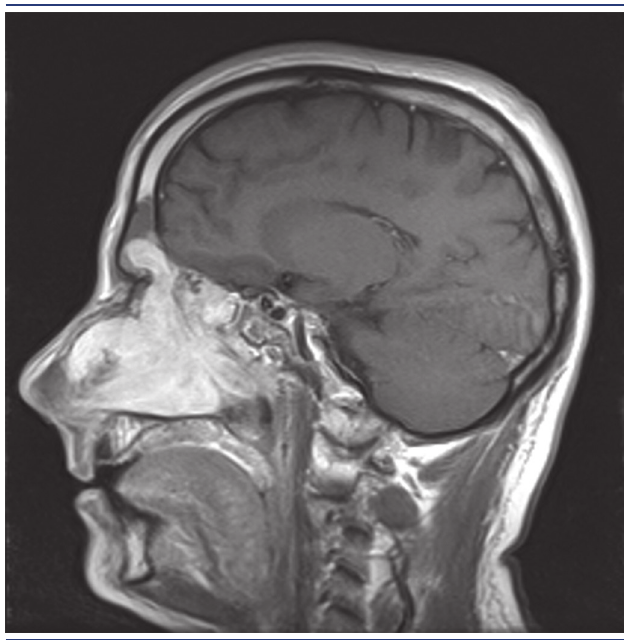
figurE 2 − MRI of sagittal section in T1 sequence after administration of gadolinium contrast, in which one observes, on the right side, lesion extension to ethmoid cells and frontal sinus MRI: magnetic resonance imaging.